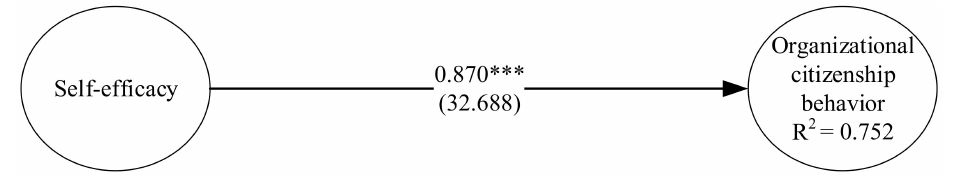
Figure 2. Self-efficacy value on organizational citizenship behavior. Note: *** refers to the significance level at